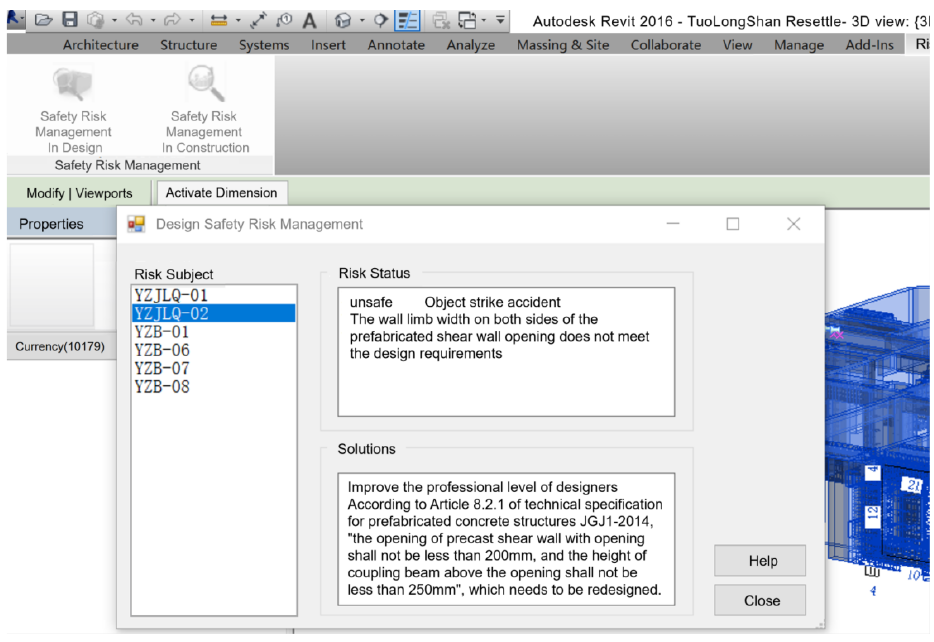
Figure 15. Operation results of the “ design safety risk management ” function.